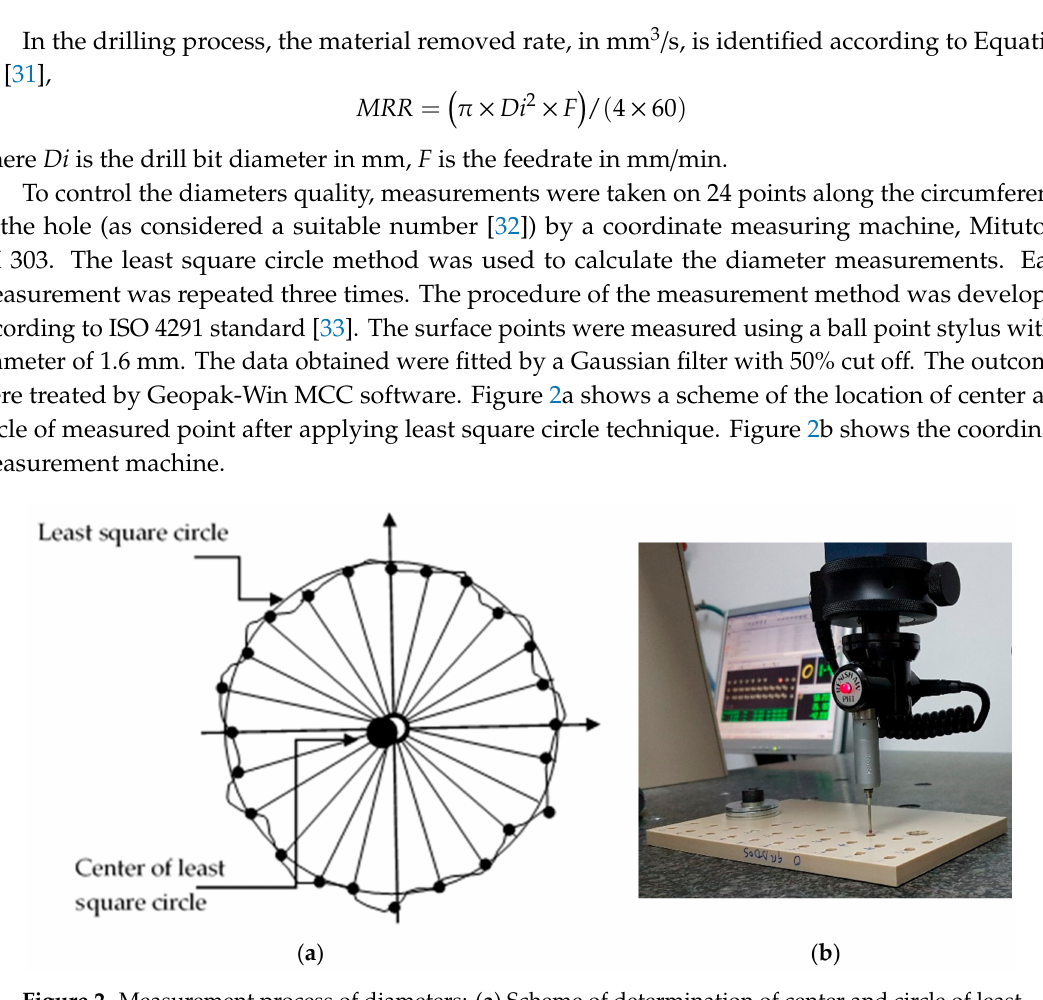
Figure 1. Machining process and data collection: ( a ) Scheme of assembly to drilling process and data capture; ( b ) Outlet of cold fluid after 8 minutes, with ice in the exterior.